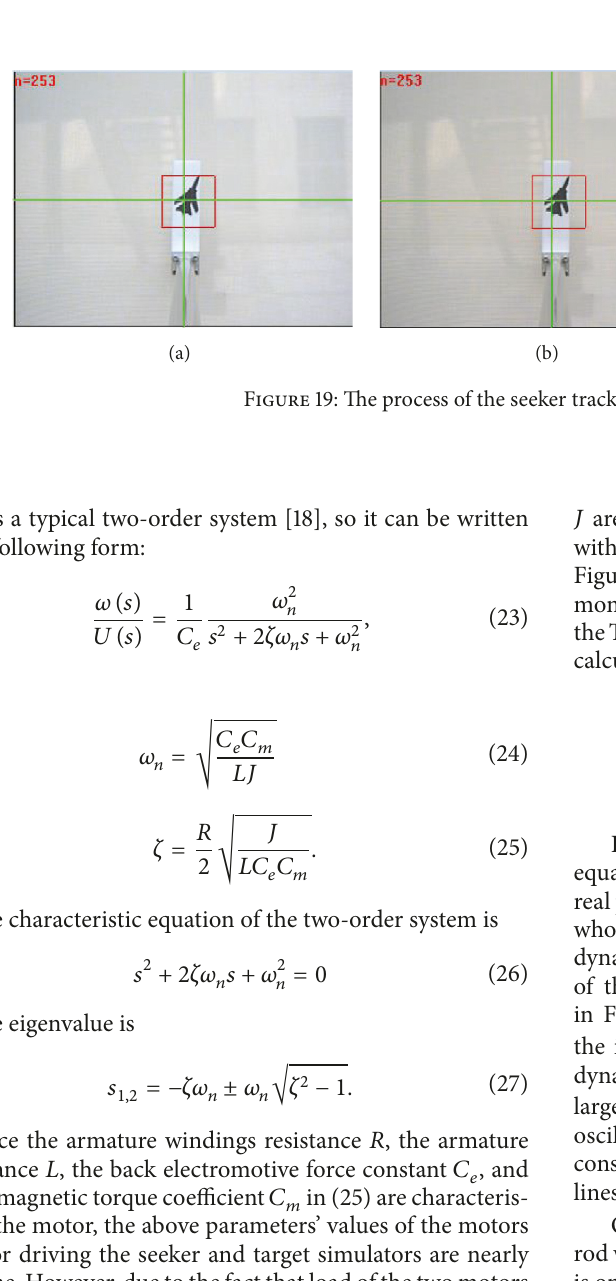
Figure 18: The process of the seeker tracking the target when 𝑘 = 1 .